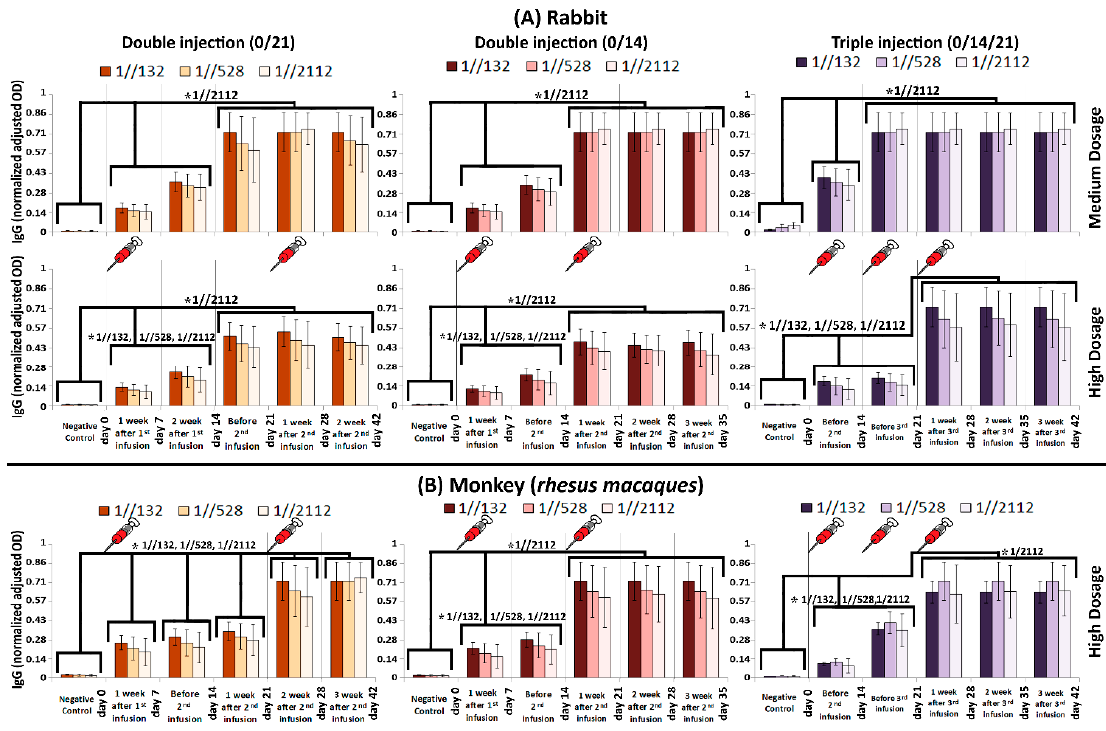
Figure 3. Humoral immunity in ( A ) Rabbit and ( B ) RM monitored via IgG titration. In case that we consider sera from infected RMs as “positive control”, the IgG (normalized adjusted OD) after 132, 528, and 2112 folds of dilution would be 1.9 ± 0.3, 2.1 ± 0.4, and 1.8 ± 0.6, respectively. The comb-like bars above the columns of the graphs represent the groups of results that came out with significant differences in IgG titration, while the schematic syringes represent days that injec- tions were carried out. The star above the comb represents which sera dilutions of comparing categories are different. For example, as what is shown in the top left panel, the IgG (normalized adjusted OD) of “Negative control” is considerably less than the interval of “day 0–14”, while the IgG (normalized adjusted OD) at “day 21–42” interval is considerably higher than both of “Negative control” and “day 0–14” interval, when the sera was diluted by 1//2112 folds. The vertical axis represents normalized adjusted OD, which is explained in Figure 2 caption. p -values of less than 0.05 were set as a cut-off for statistical significance.